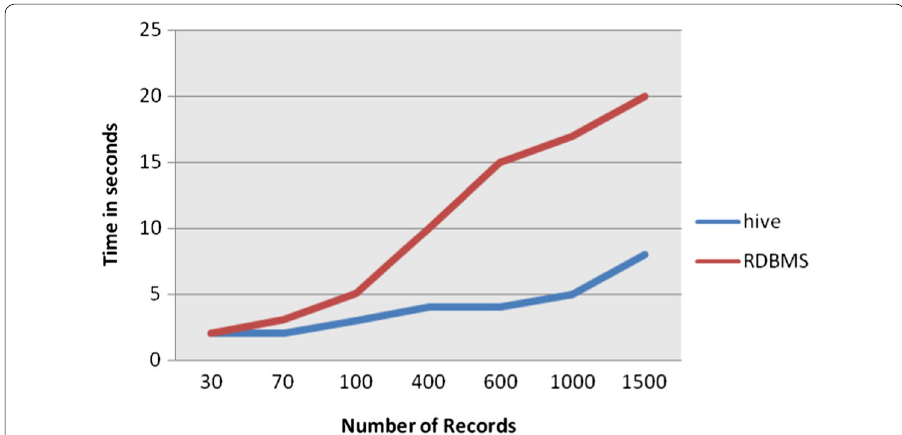
Fig. 14 Performance comparison between Hive and traditional